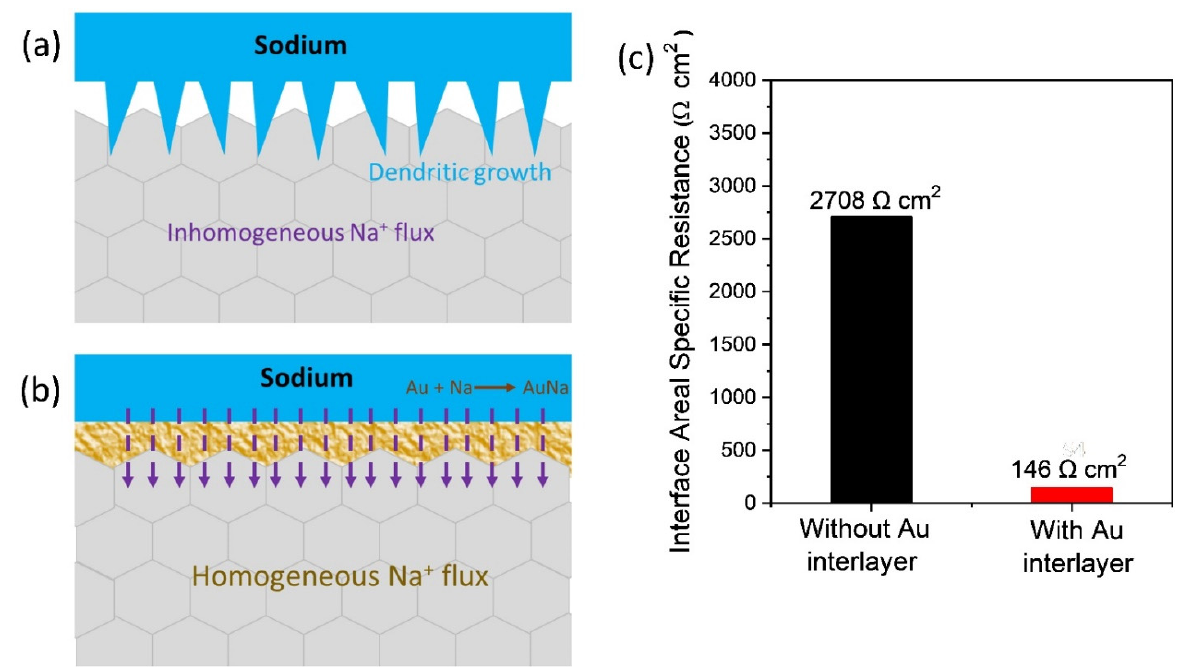
Figure 5. Schematic representation showing ( a ) a limited contact between the NZSP and Na metal, leading to huge interfacial resistance and ( b ) the better wettability of Au-NZSP, substantially enhanced through a Au interlayer, where the Na-Au alloy plays as a Na + conducting layer. ( c ) Comparison of the Na||NZSP interface-area-specific resistance (IASR), both with and without the Au interlayer.